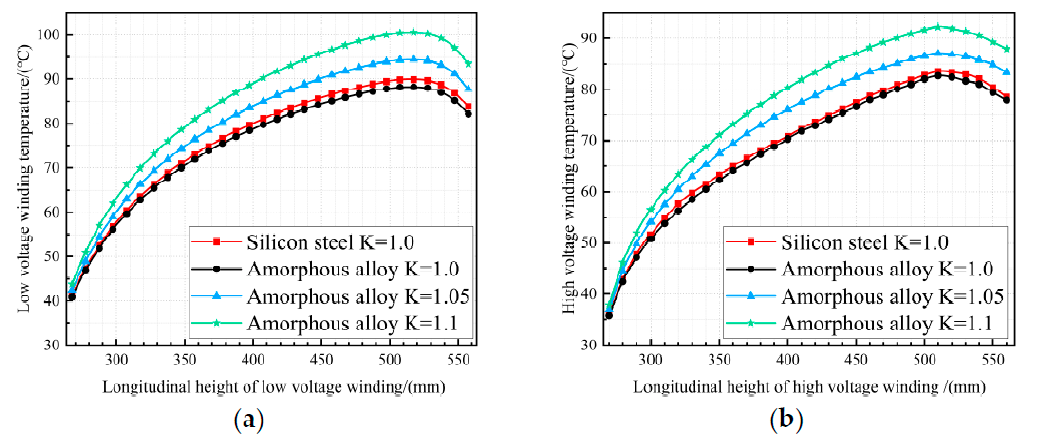
Figure 12. Temperature distribution of silicon steel transformer and amorphous alloy motor transformer. ( a ) Longitudinal temperature rise curve of low voltage winding; ( b ) longitudinal temperature rise curve of high voltage winding. Table 5. The calculated results of temperature rise. Projects